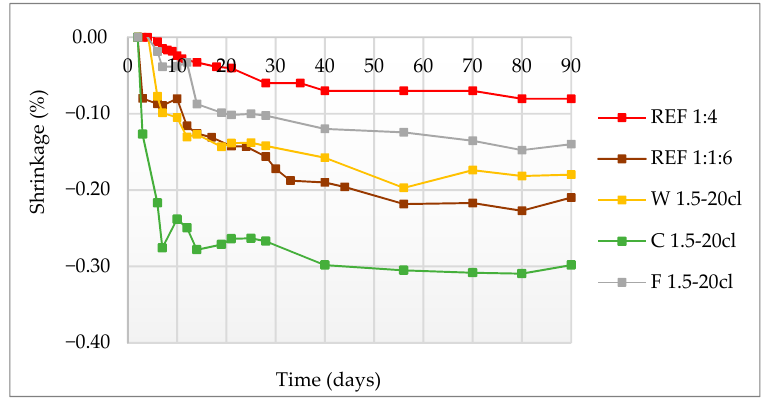
Figure 11. Shrinkage of the mortars.